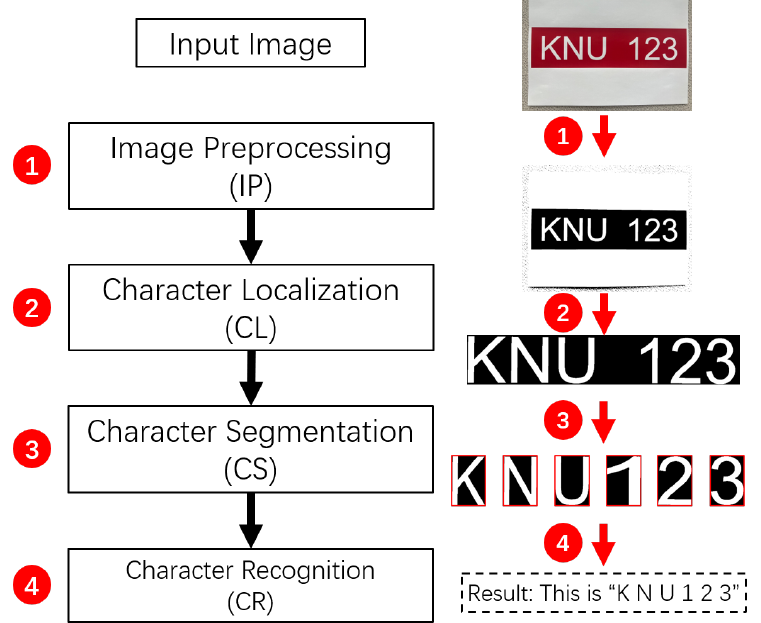
Figure 1. Four stages of the Optical Character Recognition (OCR) system for the image “KNU